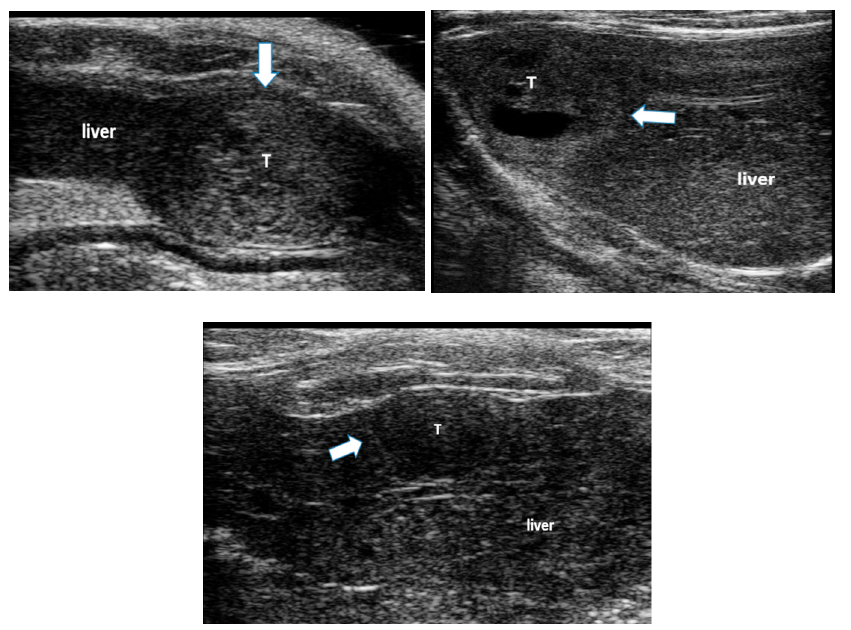
Figure 1. Examples of hepatocellular carcinoma (HCC) tumors developed in the liver of rats fol- lowing ingestion of diethylnitroseamine (DEN) for 12 weeks. The white arrows point to HCC tu- mors (T) surrounded by liver tissue. Liver tissue is hyper-echoic and coarse due to the cirrhotic